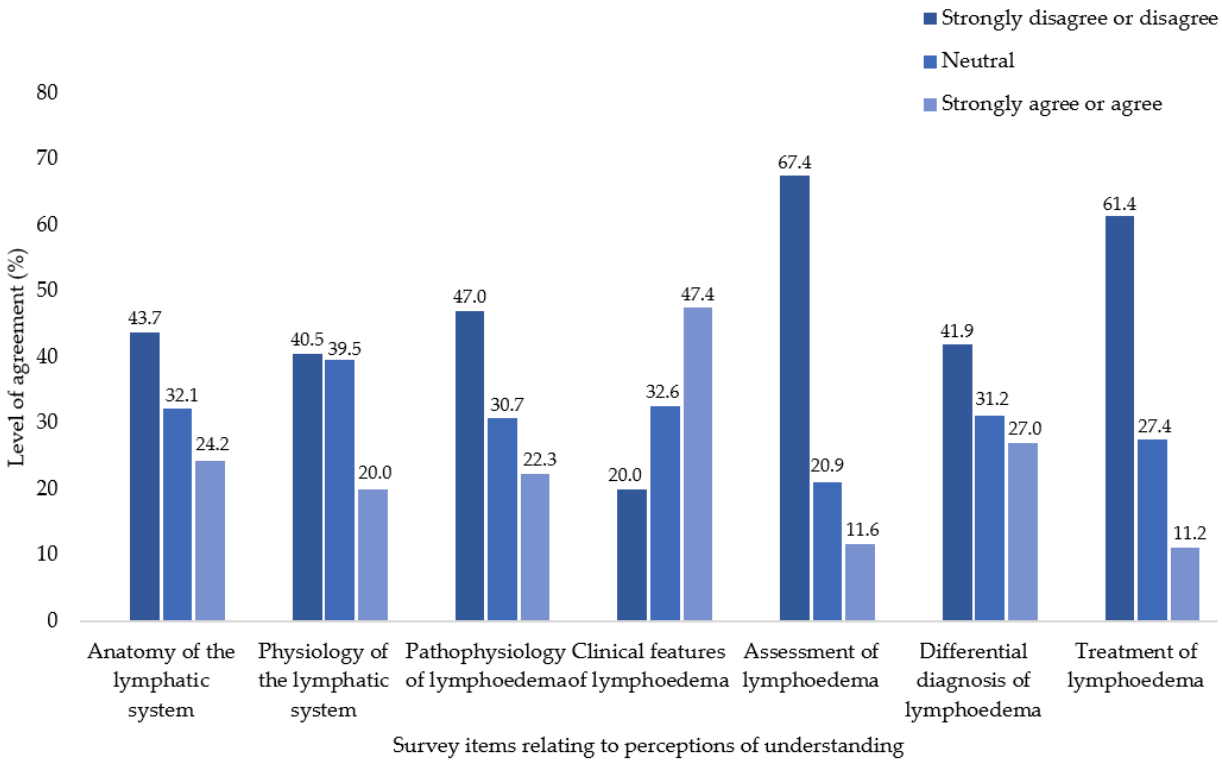
Figure 2. Level of agreement as to whether items listed are understood by medical graduates. Table 2. Subscale scores (minimum: 7; maximum: 35) for perceptions related to (i) understanding of the lymphatic system and lymphoedema, and (ii) the extent to which the lymphatic system and lymphoedema were covered in medical curricula, for the total sample and by participant character- istics.